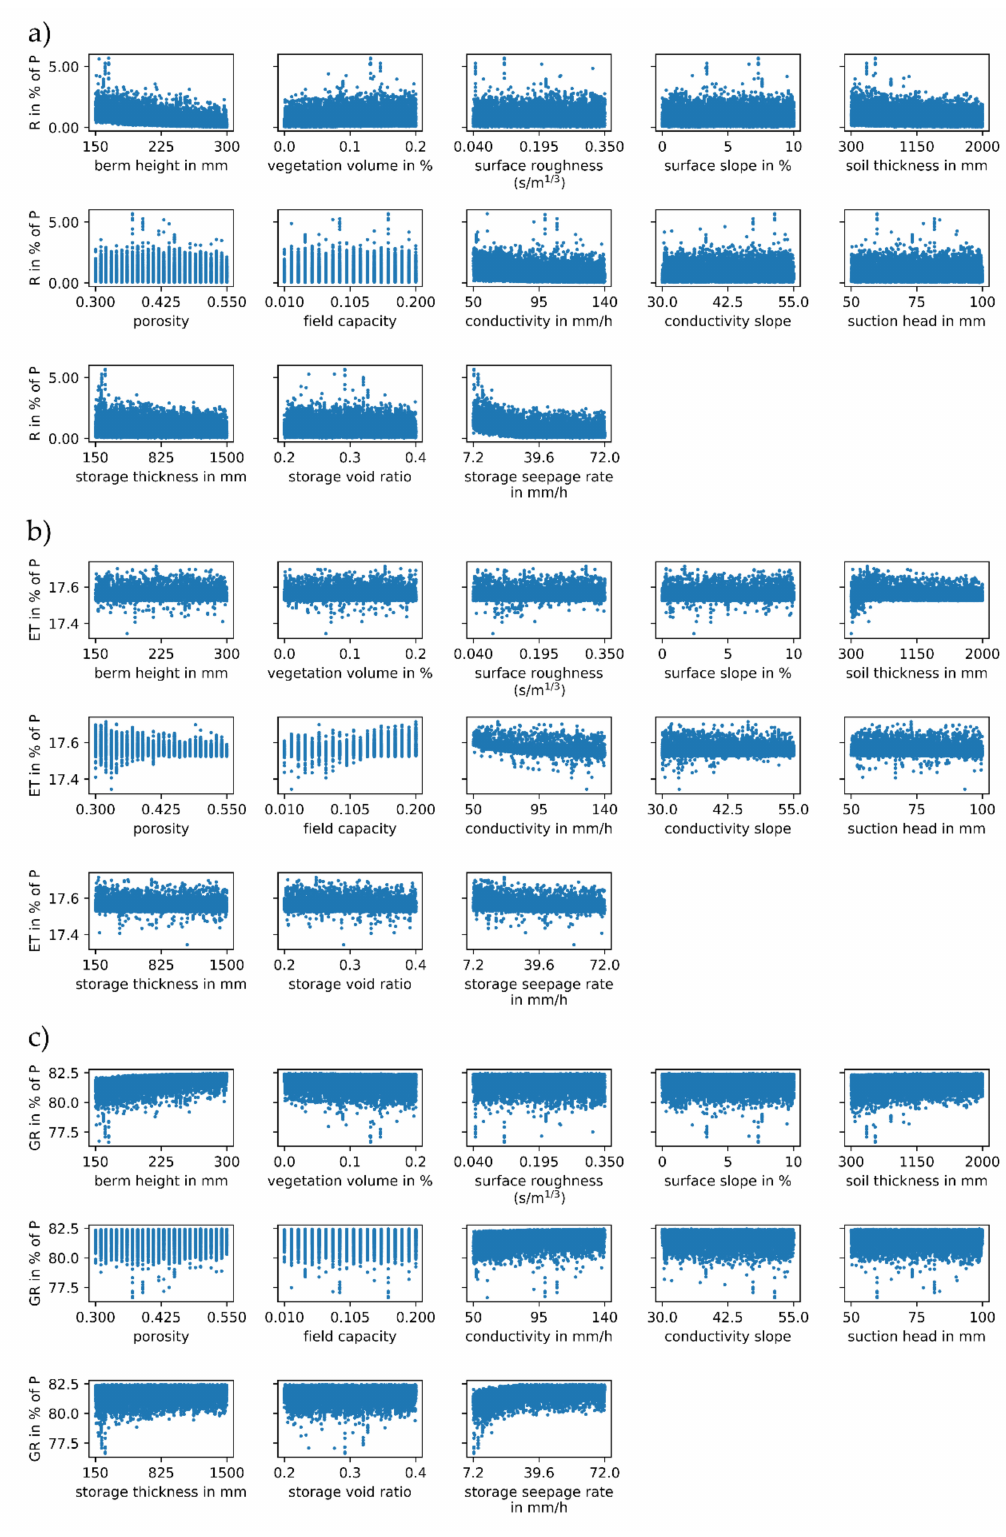
Figure 5. Results of the long-term simulations for the bio-retention cell depending on the value of the 13 bio-retention cell parameters. Each dot illustrates the result of a parameter sample. ( a ) Runoff volume (R); ( b ) evapotranspiration (ET); ( c ) groundwater recharge